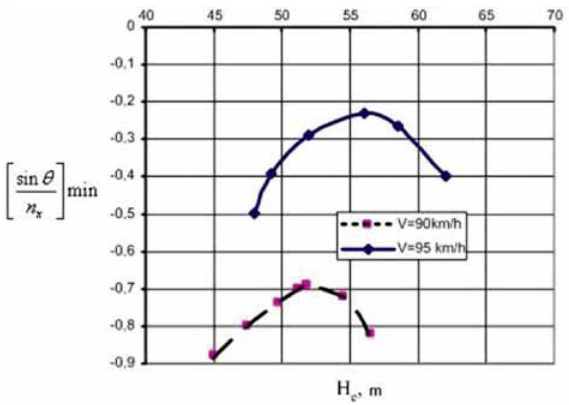
Fig. 8. Dependence of the minimum values of derivative dH/ dH e on Н е value under the condition that P = 350